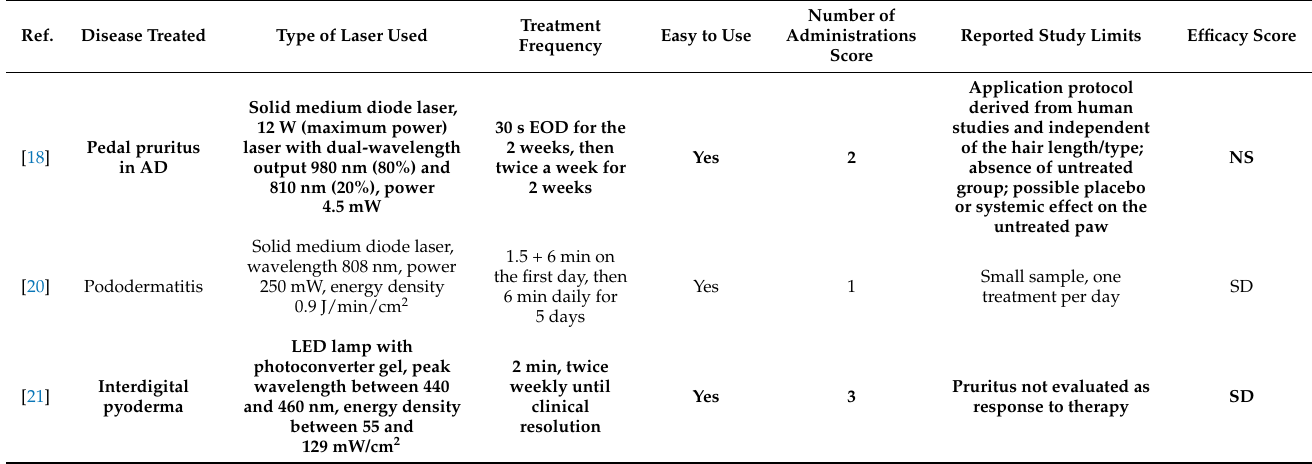
Table 3. Overall strength of LLLT in different dermatological conditions. Only conclusive, highly suggestive, and suggestive studies are